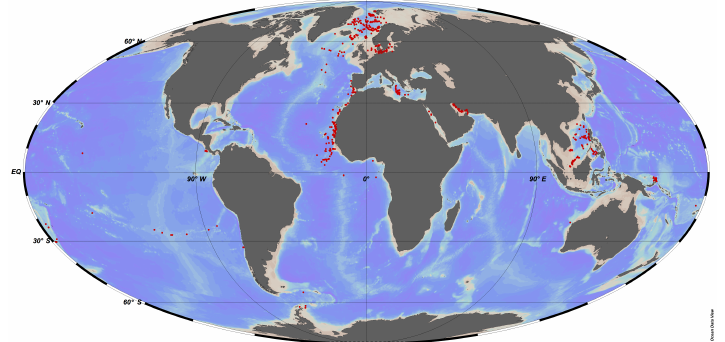
Figure 6. Map showing the locations of marine sediment cores, from which X-radiographs were obtained as part of the GIK-Archive. The cores were collected between 1965 and 2000 on a total of 93 expeditions. The cores are listed in table in https://doi.org/10.1594/PANGAEA.